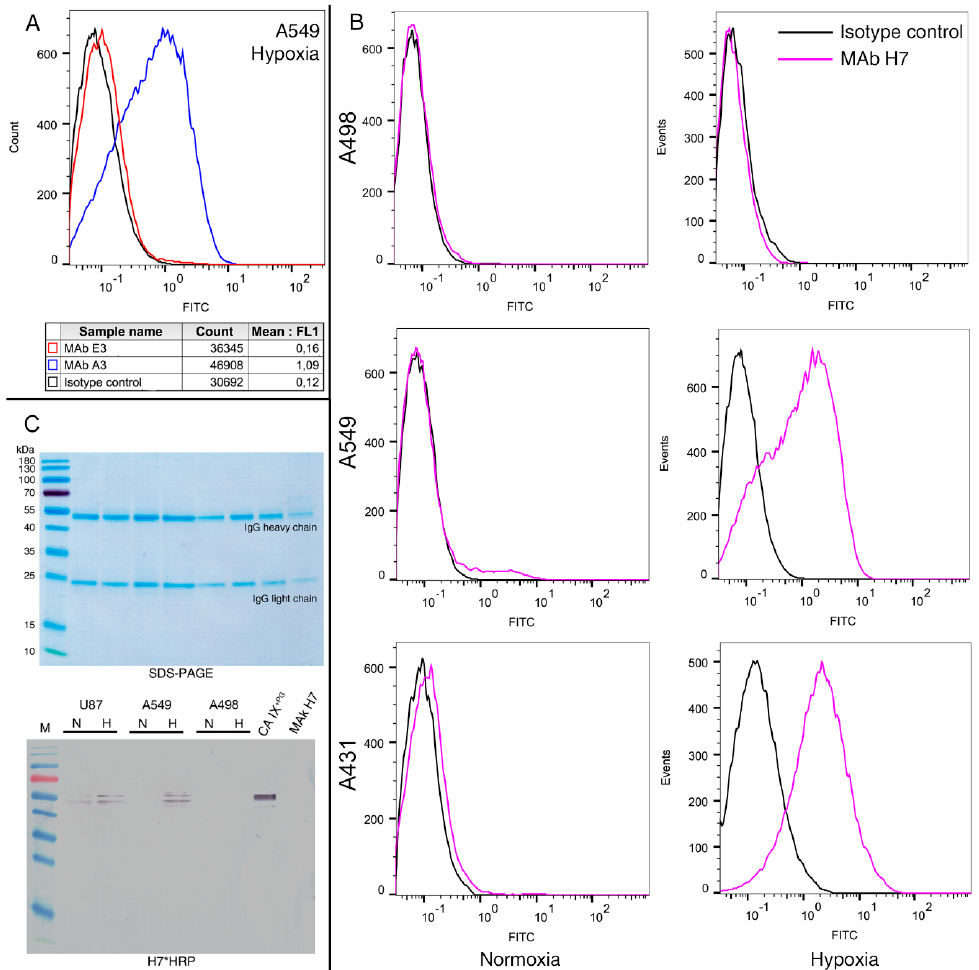
Figure 2. ( A ) Flow cytometry fluorescence histograms of A549 cells grown in hypoxia and